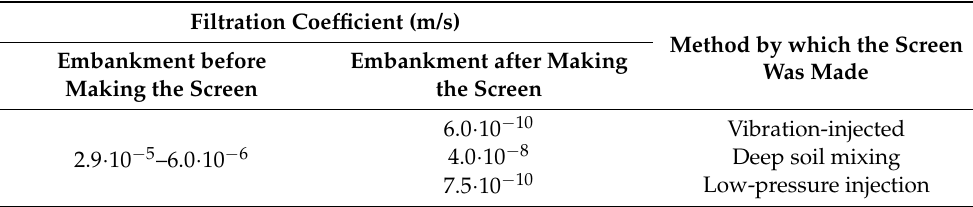
Table 4. Results of the filtration coefficient tests in the field conditions.